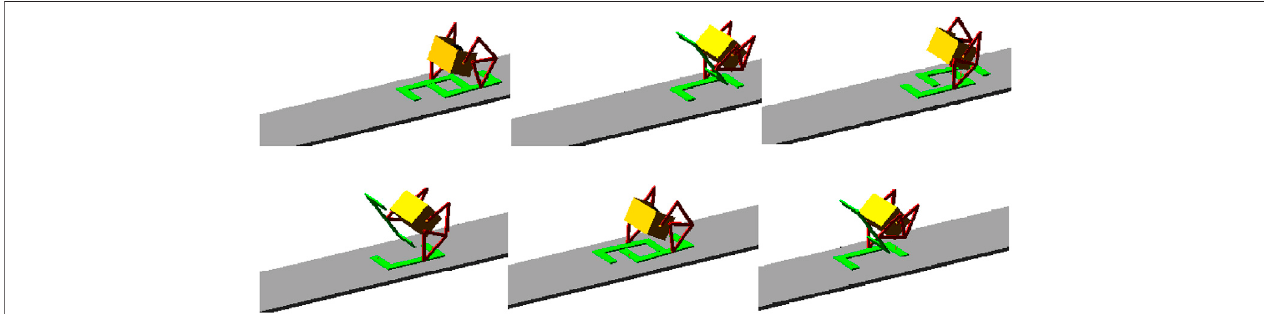
FIGURE 9 | Snapshots of the simulation when robot moving